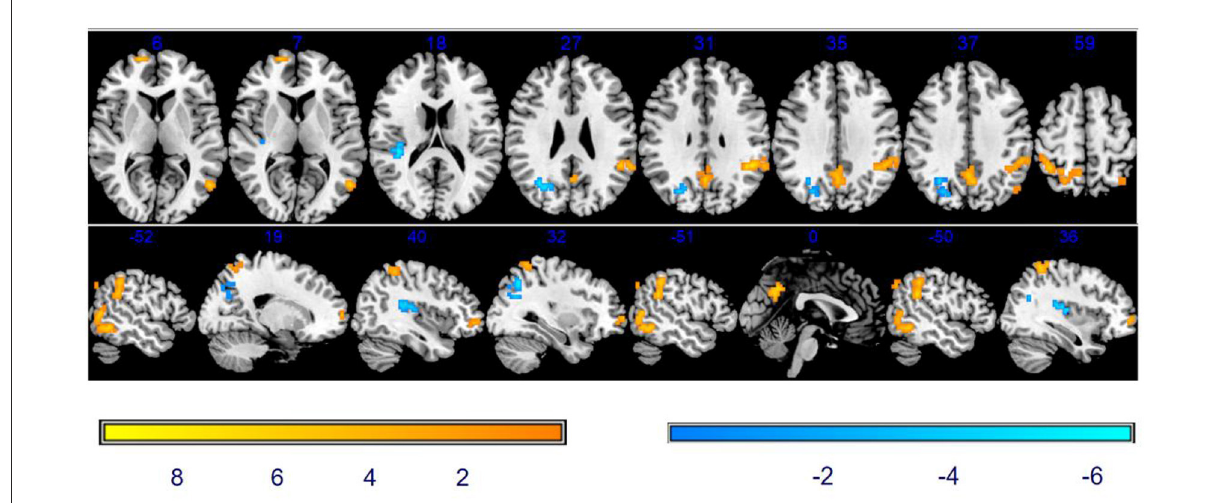
FIGURE3 Significant differences in ReHo between baseline and after stSCS in axial and sagittal slices. The warm colors indicate a higher ReHo value whereas the cooler colors indicate a lower ReHo value at baseline and after stSCS ( p < 0.05). Brain images are displayed in radiology convention (the left of the figure represents the right side of the patient’s brain and vice versa ).